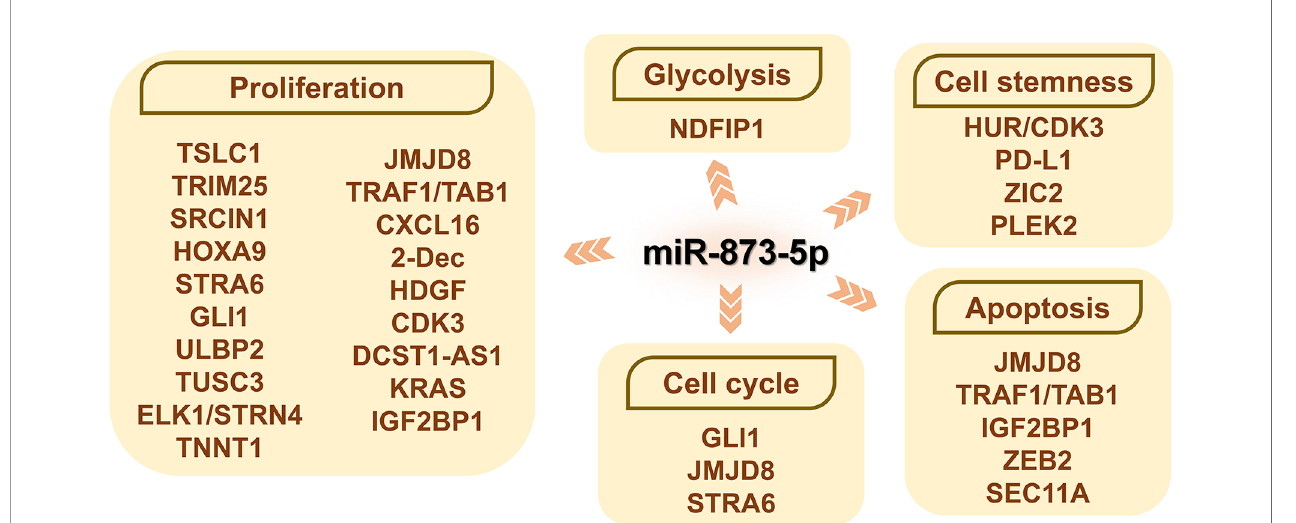
FIGURE 4 | The role of miR-873-5p and its target genes on the cell biology of cancer cells. By promoting or inhibiting cell proliferation and apoptosis, miR-873-5p has both oncogenic or pro-cancer effects in different cancers. miR-873-5p inhibits the aerobic glycolysis of cancer cells by targeting NDFIP1. In addition, miR-873-5p can reduce the stemness of cancer cells by targeting PD-L1 and HUR/CDK3. By targeting GLI1, JMJD8, IGF2BP1, and STRA6, miR-873-5p can inhibit the progression of the cancer cell